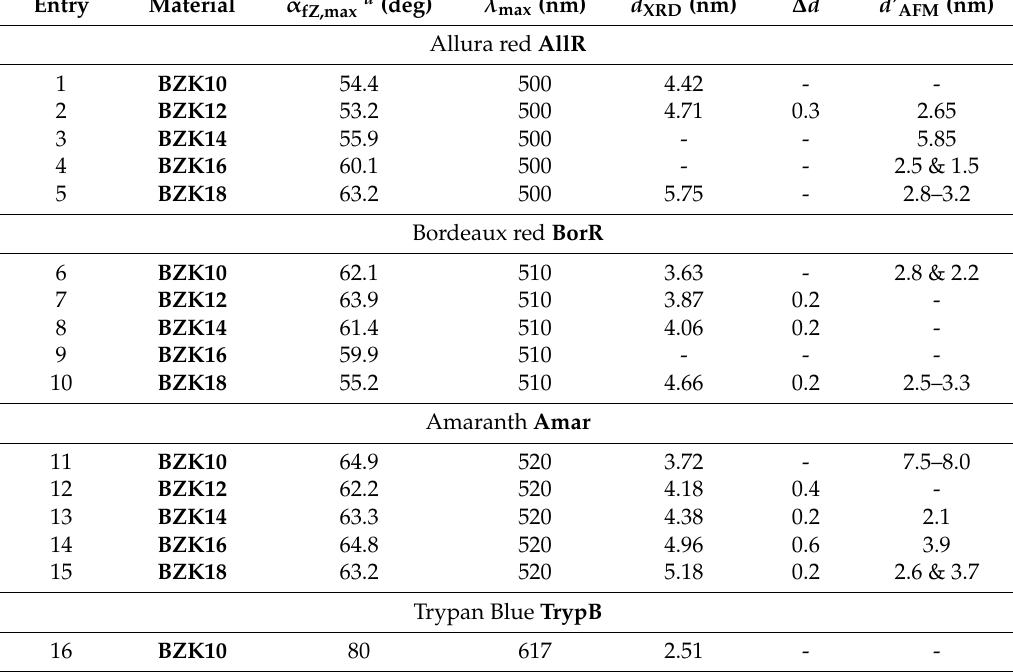
Table 2. Structural information from polarized optical spectroscopy on thin films of ionic self-assembled material based on Allura Red, Bordeaux red and Amaranth anionic azo-dyes and benzalkonium surfactants with alkane tail of varying length (from –(CH 2 ) 9 CH 3 to –(CH 2 ) 17 CH 3 ): The average angle (respect to the surface normal) of the transition moment corresponding to primary transition α fZ,max and maximum of primary transition λ max . Direct structural information from: terrace heights d’ determined from AFM micrographs of the same thin films, and layer separation d determined in bulk powder using XRD. The difference in layer spacing ∆ d was calculated using the XRD data. Entry Material α fZ,max a (deg) λ max (nm) d XRD (nm) ∆ d d’ AFM (nm) Allura red AllR